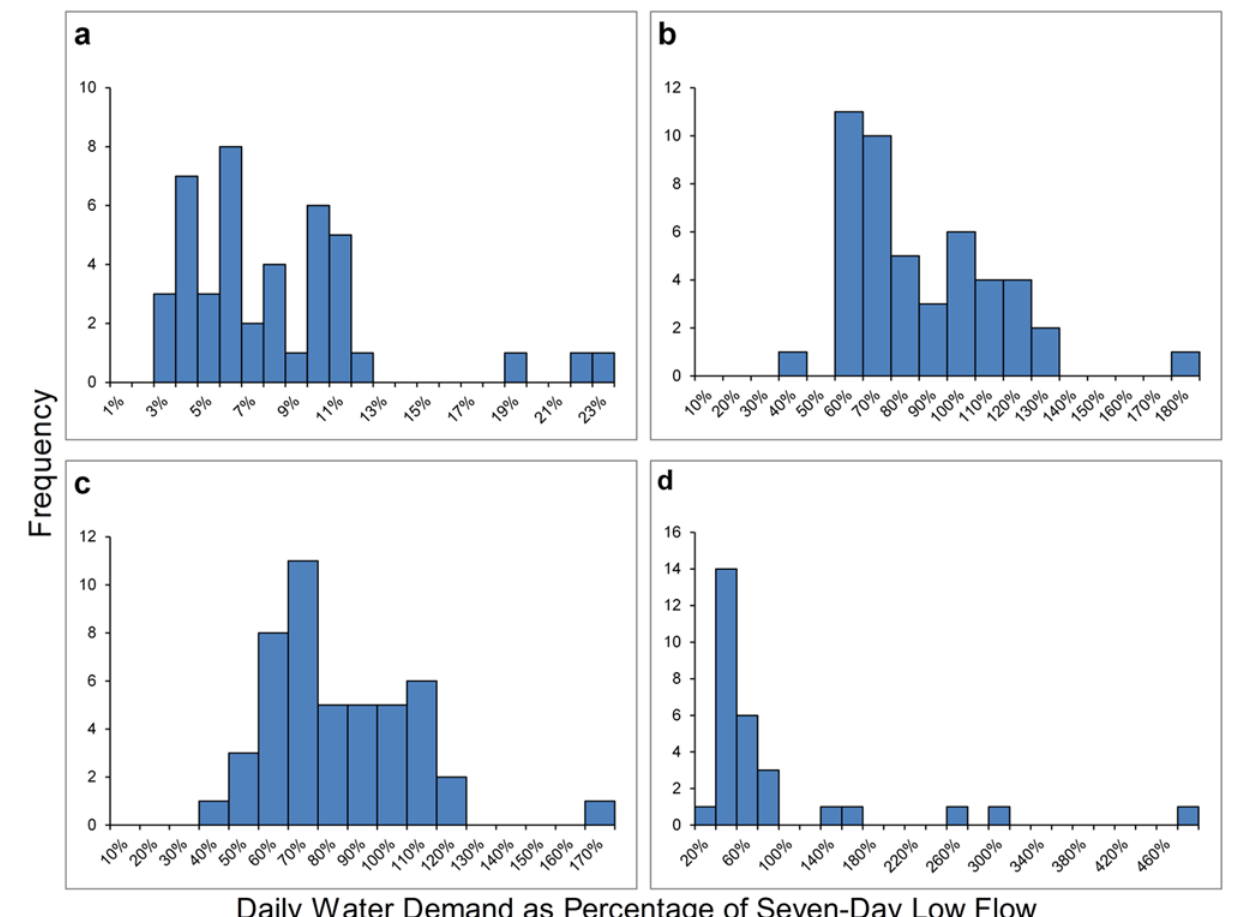
Fig 8. Frequency distribution of the water demand for marijuana cultivation as a percentage of seven-day low flow by year in each study watershed. Water demand data are from a remote sensing exercise using aerial imagery from 2011 – 2012 and are compared with each year ’ s annual seven- day low flow value for the period of record in each study watershed: (a) Upper Redwood Creek watershed (USGS gage near Blue Lake, CA, coverage from water year (WY) 1954 – 1958 and 1973 – 2014), (b) Salmon Creek watershed (data modeled using USGS gage on Elder Creek, CA, coverage from WY 1968 – 2014), (c) Redwood Creek South (data modeled using USGS gage on Elder Creek, CA, coverage from WY 1968 – 2014), and (d) Outlet Creek (USGS gage near Longvale, CA, coverage from WY 1957 – 1994). Data from WYs 1977, 1981, 1987 – 1989, and 1991 – 1994 are excluded from Outlet Creek watershed due to seven-day low flow values of zero at the gage. Water demand as a percentage of seven-day low flow would be > 100% in these years, but we cannot determine by how much.